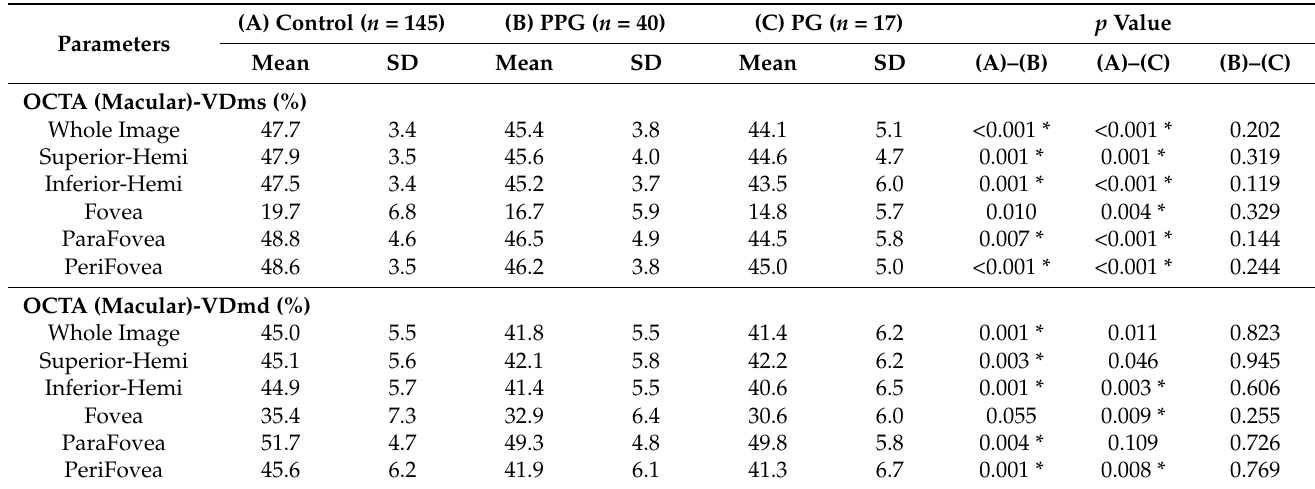
Table 3 revealed that the most sensitive parameters for discerning the control group